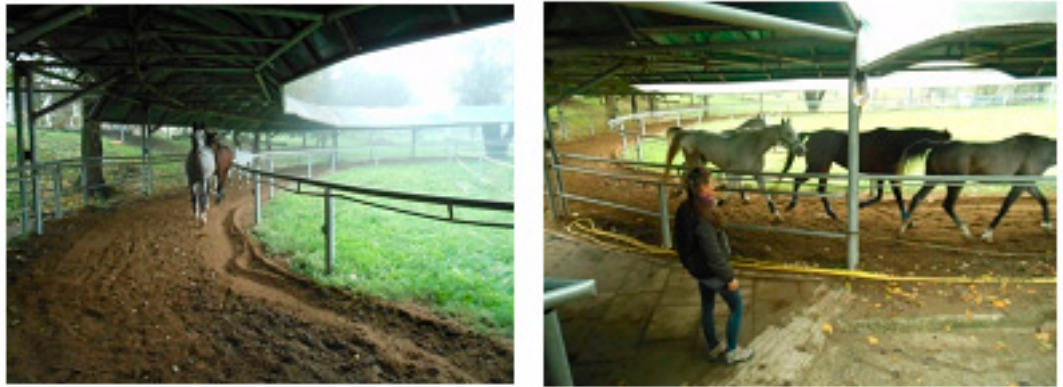
Figure 3. Walker where the horses were trained.